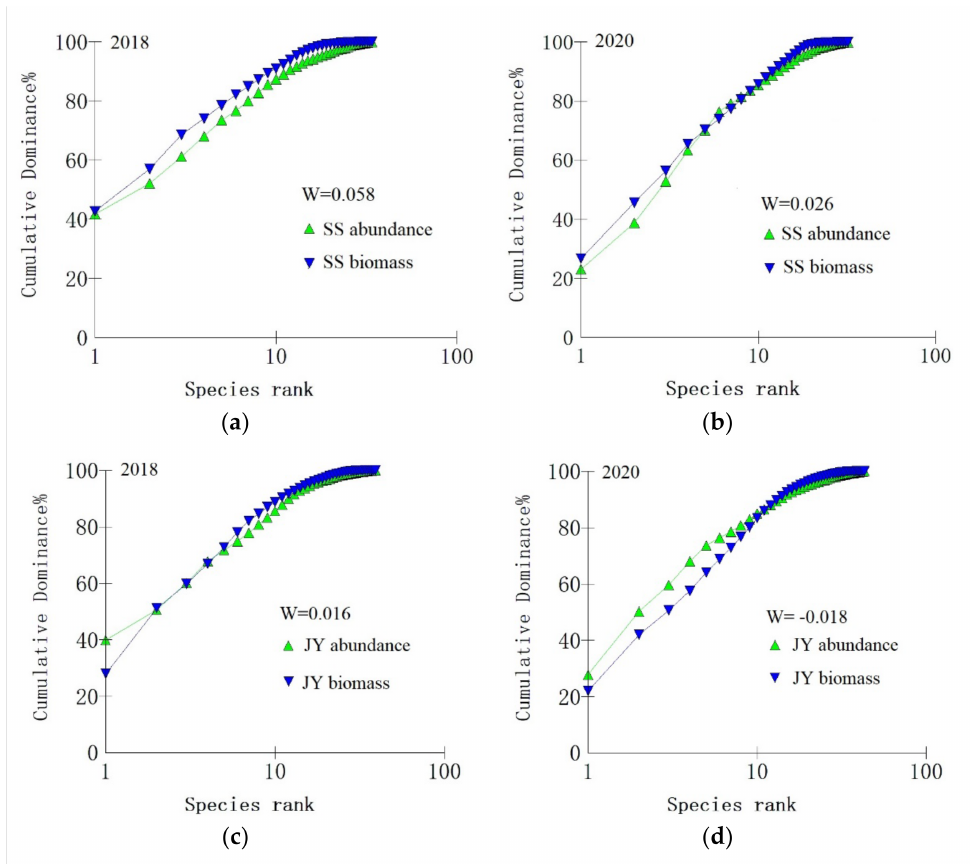
Figure 5. Abundance − biomass comparison curves (ABC) and W − statistics of fish communities in the Shishou ( a , b ) and Jiayu ( c , d ) river reaches in different